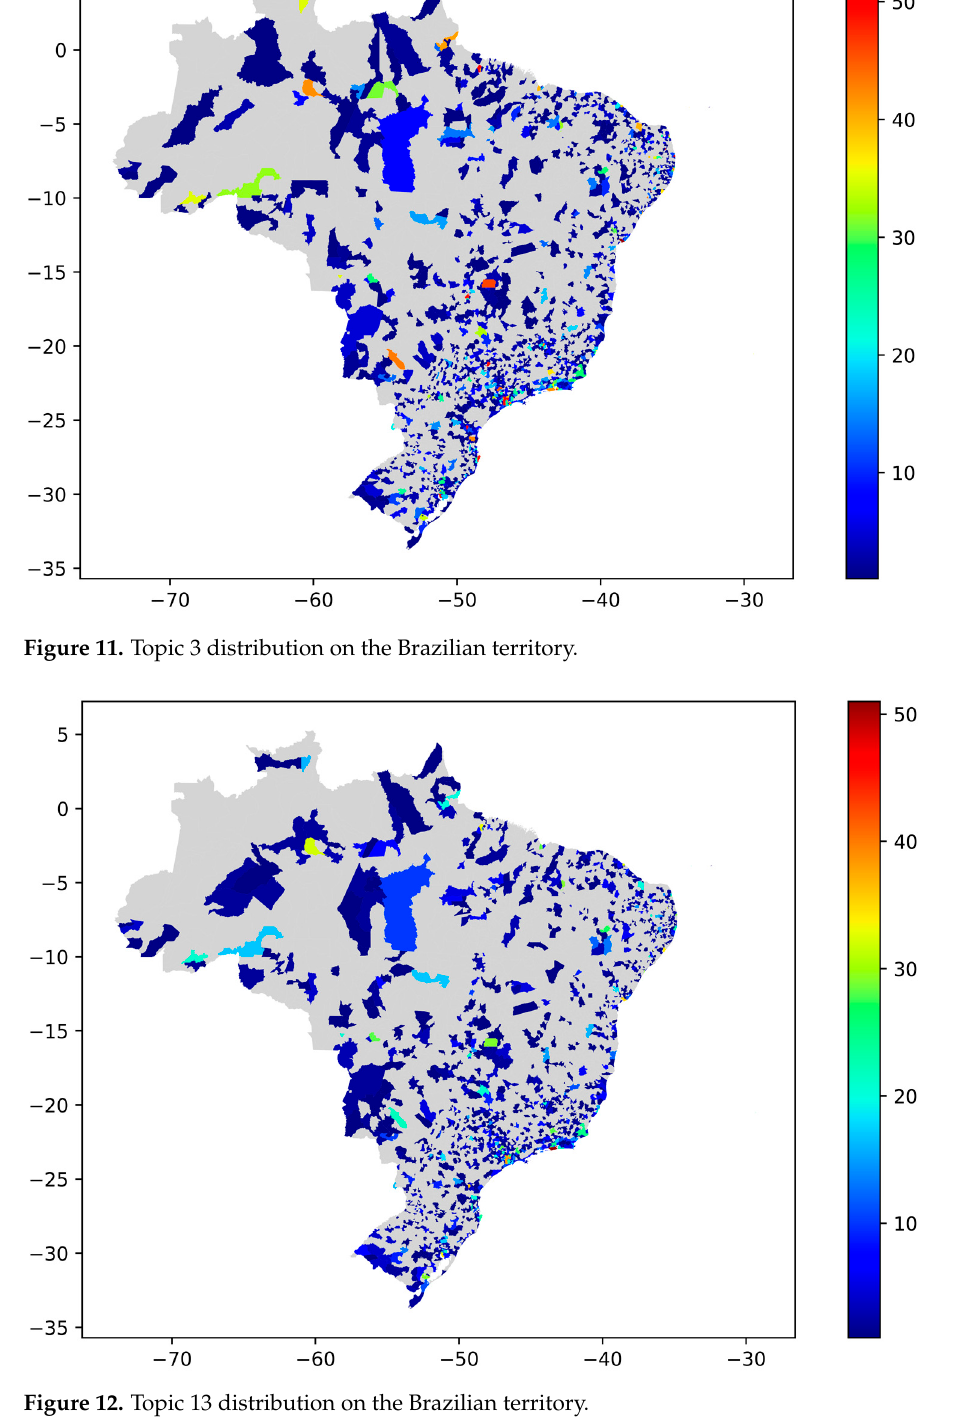
Figure 12. Topic 13 distribution on the Brazilian territory.